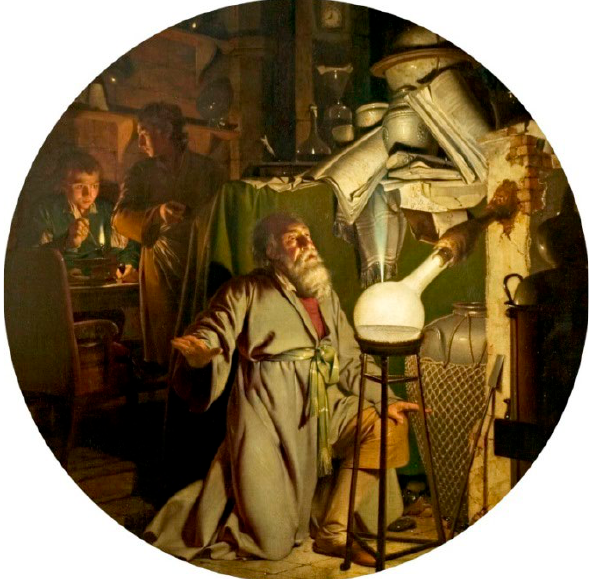
Figure 2. Detail from Joseph Wright of Derby’s painting of 1771 showing an alchemist discovering phosphorus. Source: https:// resobscura.blogspot.com/2017/06/urine-phosphorus-and-philoso-